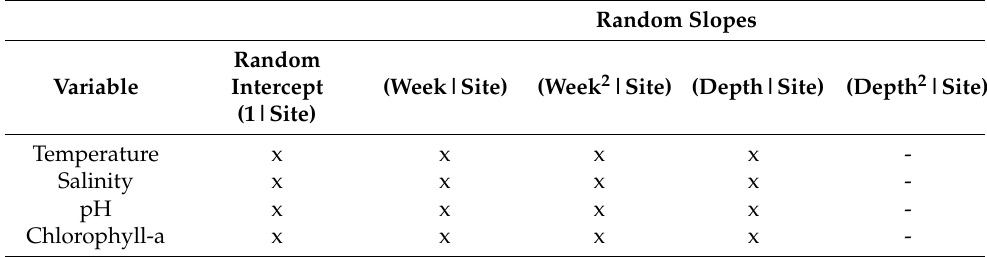
Table 5. Site-level random terms included (x) and excluded (-) in best-performing random slope